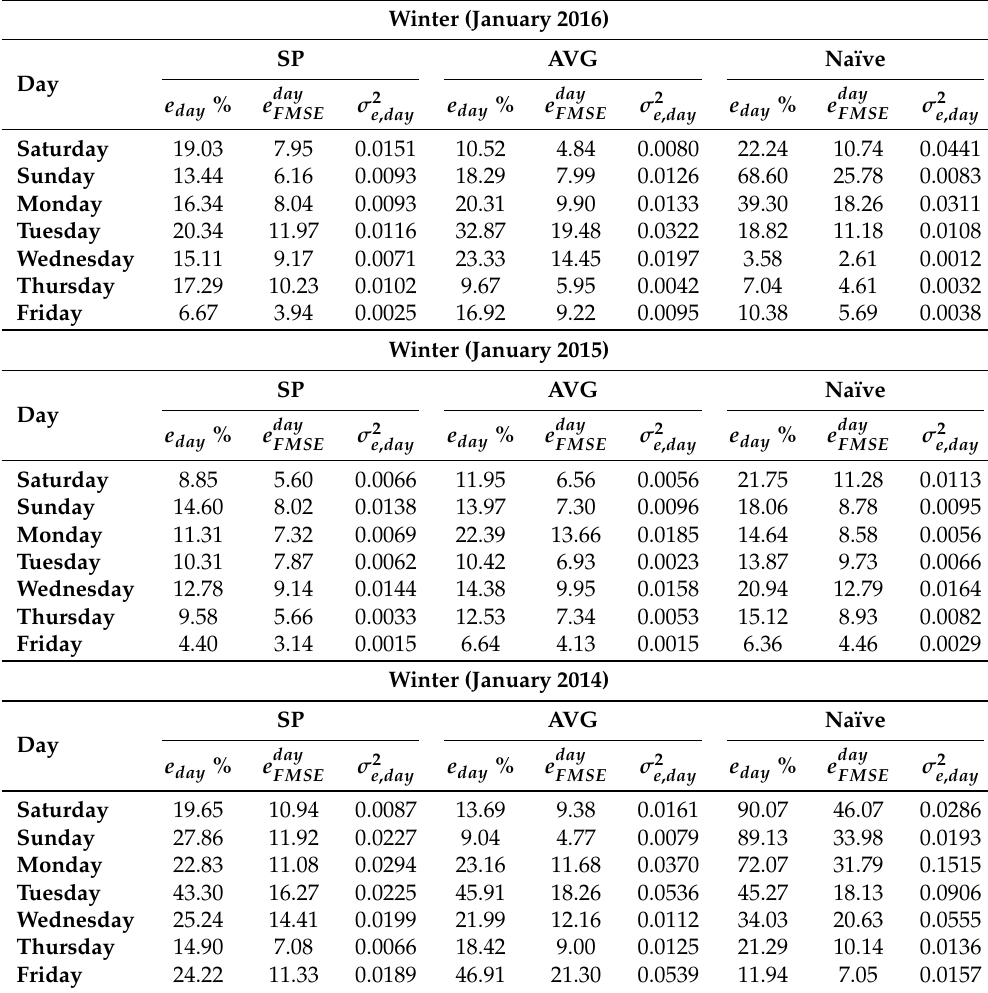
Table 7. e day (%), e day and σ 2 of winter of 2016, 2015 and 2014 for the SP model, average (AVG) FMSE e , day and naïve models.